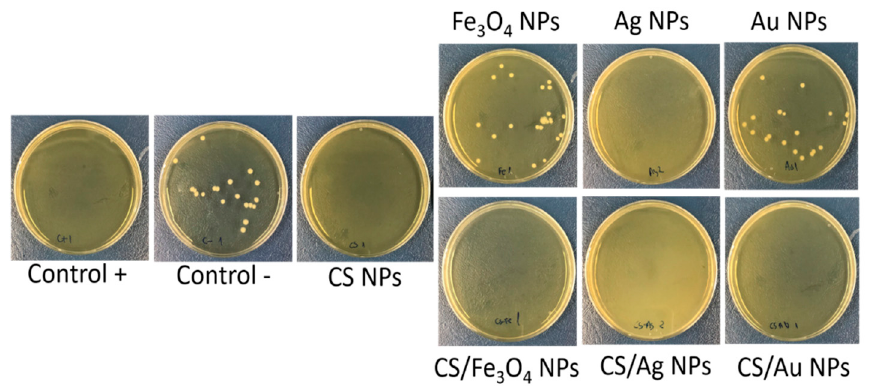
Figure 5. Antibacterial activity of CS based hybrid NPs compared to respective inorganic NPs measured by their ability to inhibit E. coli colonies formation.